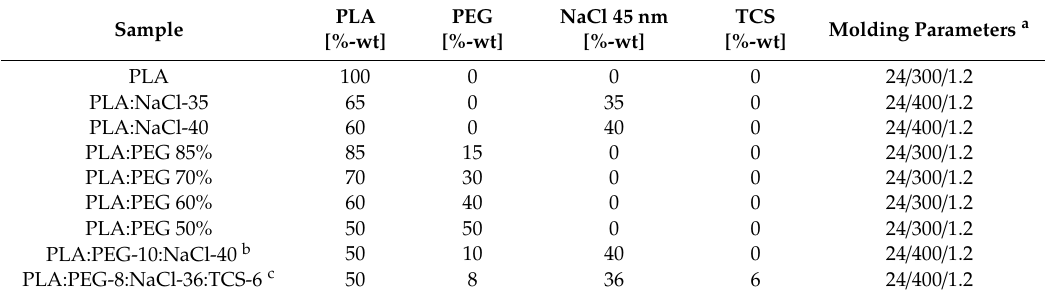
Table 1. Abbreviation, composition and processing parameters of the studied